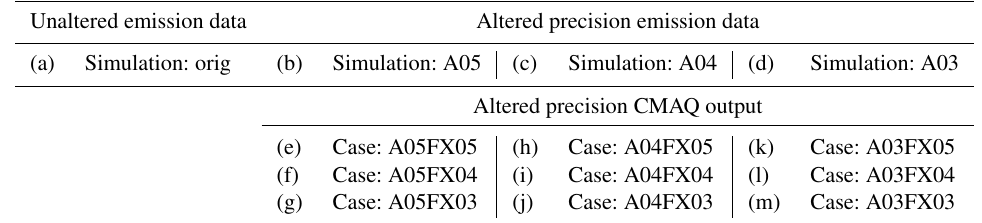
Table 2. Setup of all simulations (orig, A05, A04, and A03) and cases analyzed in this study. Unaltered emission data